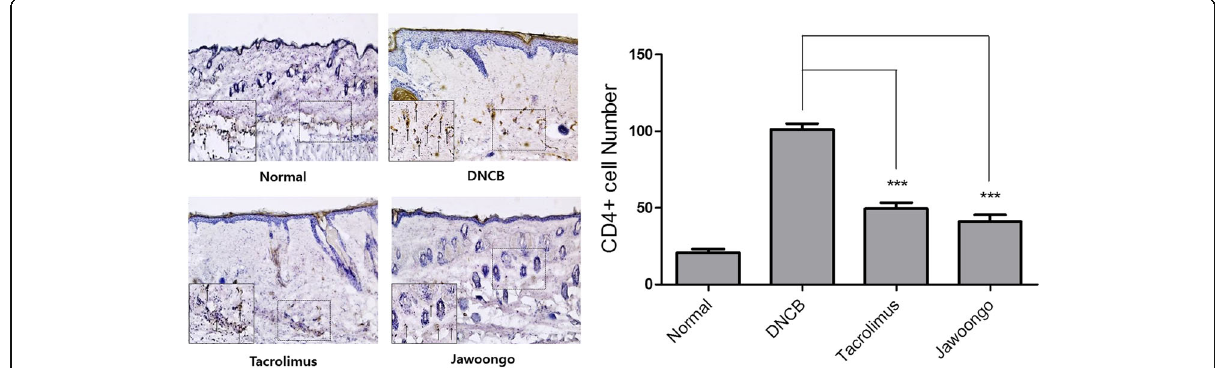
Fig. 6 Distribution of CD4+ cells in the skin of mice with DNCB-induced AD. Skin sections were immunostained with CD4+ antibodies. CD4+ cells display a brown color. The sections were evaluated under a microscope at an original magnification of 200×